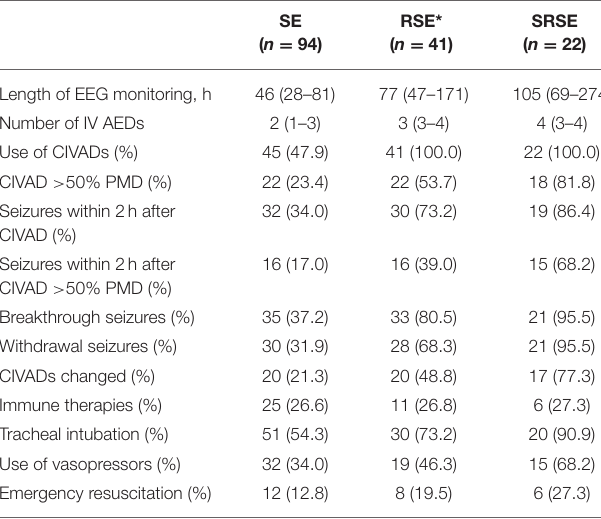
TABLE 3 | NICU management and treatment responses of status epilepticus in acute encephalitis.